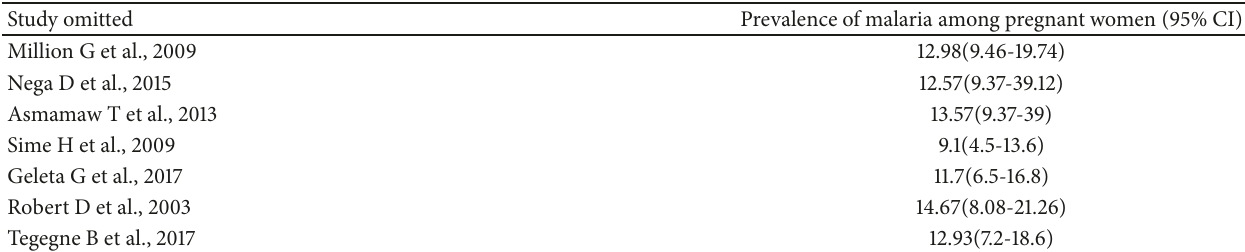
Table 2: Sensitivity analysis of the included studies to estimate the pooled prevalence of malaria among pregnant women. Study omitted Million G et al.,